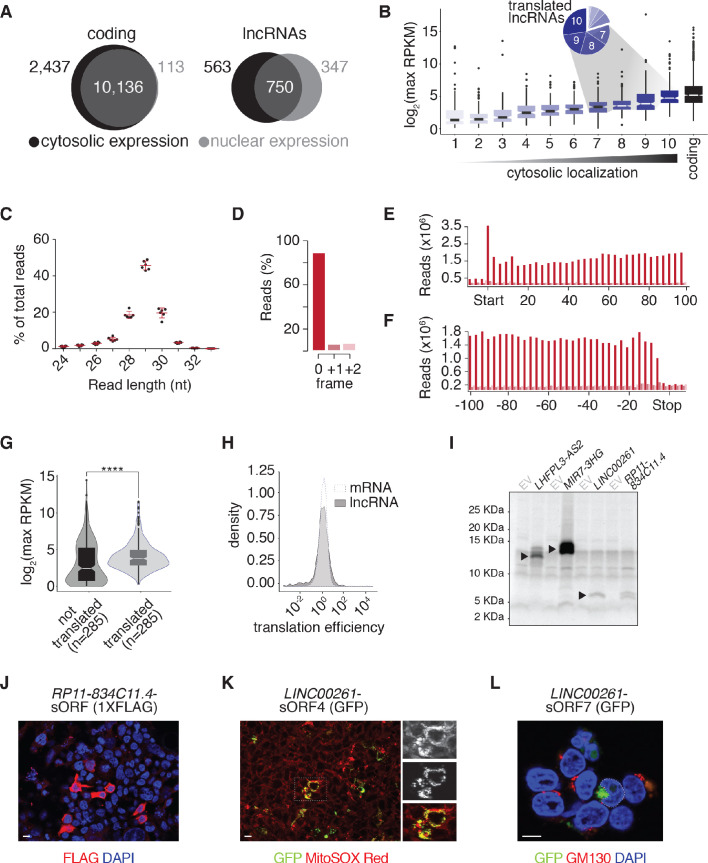
Cytosolic lncRNAs engage with ribosomes.(A) Venn diagrams showing the number of coding RNAs (left) and lncRNAs (right) with RPKM ≥ 1 across two biological replicates in cytosolic and nuclear fractions. (B) Box plots of maximum lncRNA expression (RPKM + pseudocount) across 38 tissues binned by their degree of cytosolic localization (measured as nuclear/cytosolic lncRNA expression ratio deciles in PP2); the expression of all PP2-transcribed coding RNAs with dynamic expression during differentiation is included for reference. The pie chart summarizes the proportions of translated lncRNAs within each cytoplasmic localization decile. (C) Read length distribution (nt) of Ribo-seq fragments across replicate Ribo-seq experiments (n = 6 biological replicates). (D) Position of the inferred P-sites of the ribosome footprints relative to the reading frame of PP2-transcribed coding genes. (E–F) Coverage of 29 nt footprint P-sites around the start codons (E) or stop codons (F) of PP2-transcribed coding genes. (G) Box plots comparing maximum expression of translated and untranslated lncRNAs (RPKM + pseudocount) across 38 tissues (****, p-value=2.122×10−8, Wilcoxon rank sum test). For the untranslated set, 285 untranslated PP2-expressed lncRNAs were selected randomly. (H) Density plots comparing the translation efficiencies of PP2-expressed mRNAs and lncRNAs. (I) Autoradiograph of radiolabeled in vitro translation products derived from full-length LHFPL3-AS2, MIR7-3HG, LINC00261, and RP11-834C11.4. EV, empty vector. (J) Anti-FLAG immunofluorescence staining of HEK293T cells transiently transfected with a PGK-RP11-834C11.4-sORF-1xFLAG construct. (K) Microphotograph of HEK293T cells transiently transfected with a PGK-LINC00261-sORF4-GFP construct with mitochondria labeled by MitoSOX Red. (L) Golgi immunofluorescence staining (anti-GM130) of HEK293T cells transiently transfected with a PGK-LINC00261-sORF7-GFP construct. Scale bars = 10 µm.